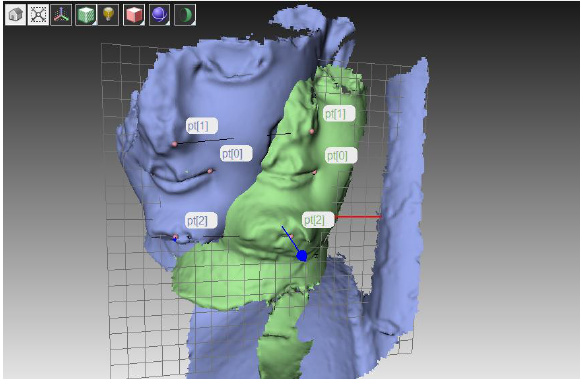
Figure 13. Global registration in Geomagic Studio